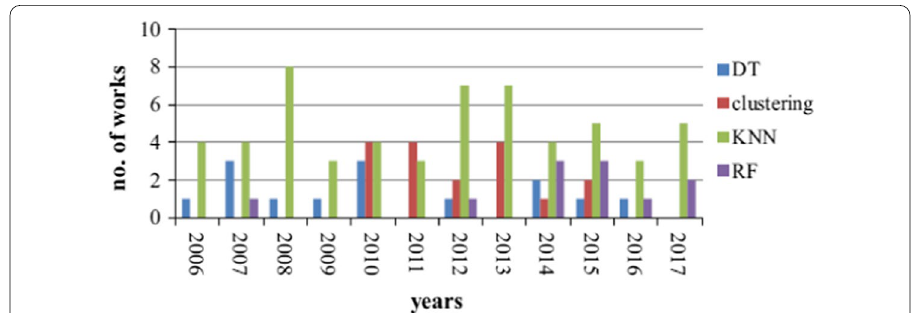
Fig. 3 Distribution in the number of studies using DT, clustering, KNN, and RF techniques